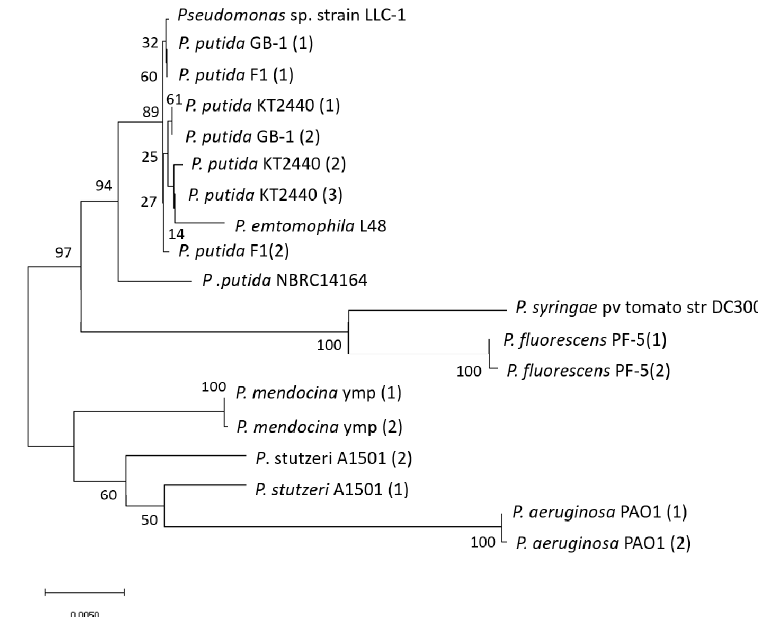
/ ENA / DDBJ Accession